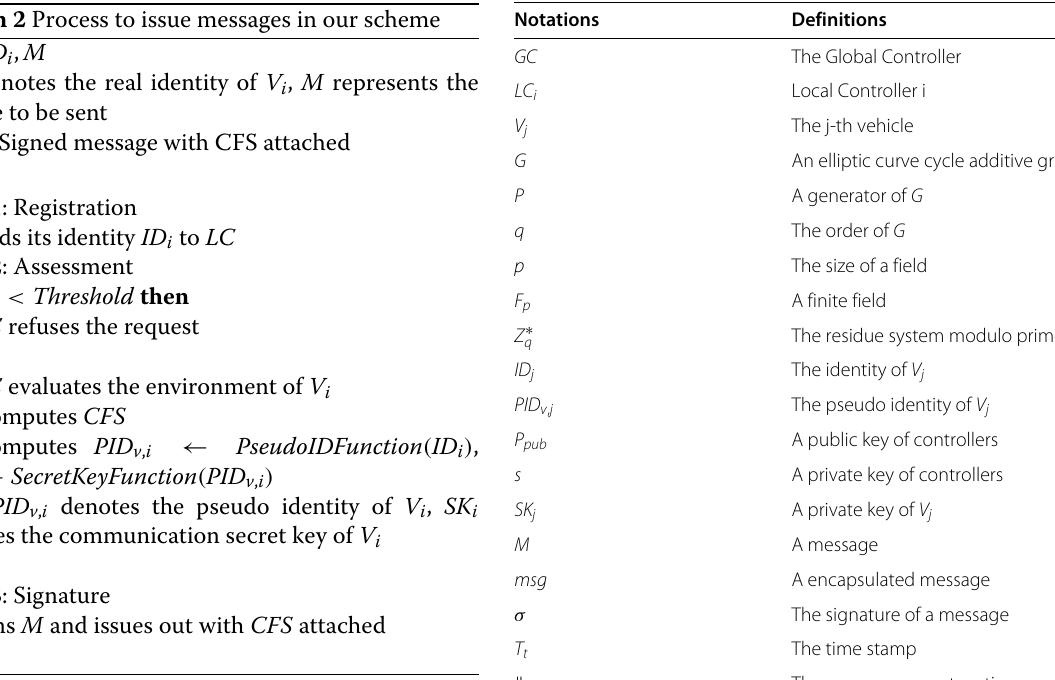
Table 1 Notations and